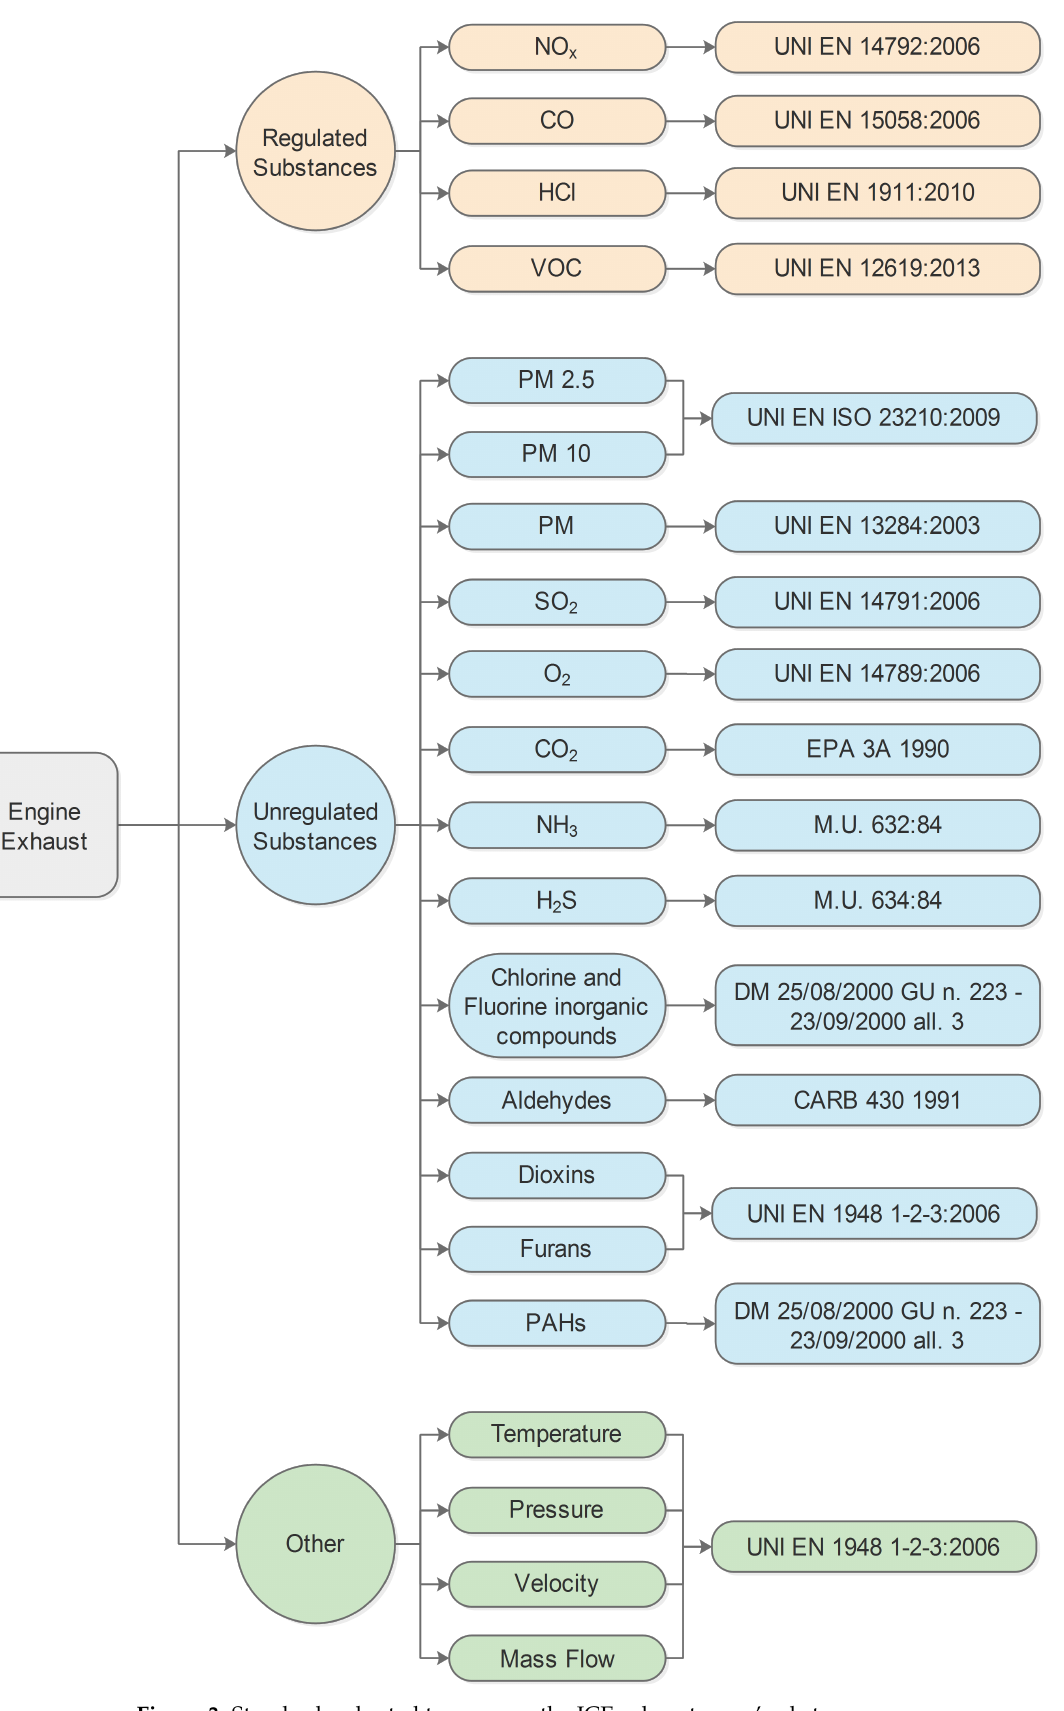
Figure 3. Standards adopted to measure the ICE exhaust gases’